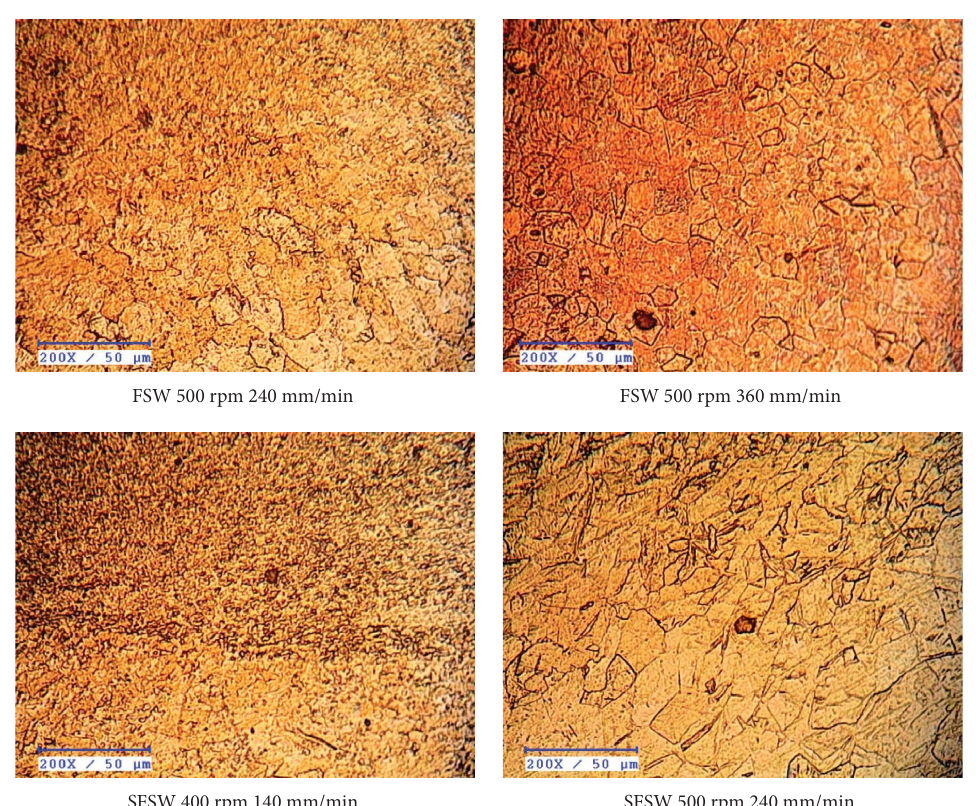
Figure 8: Optical microscopic images of the welded